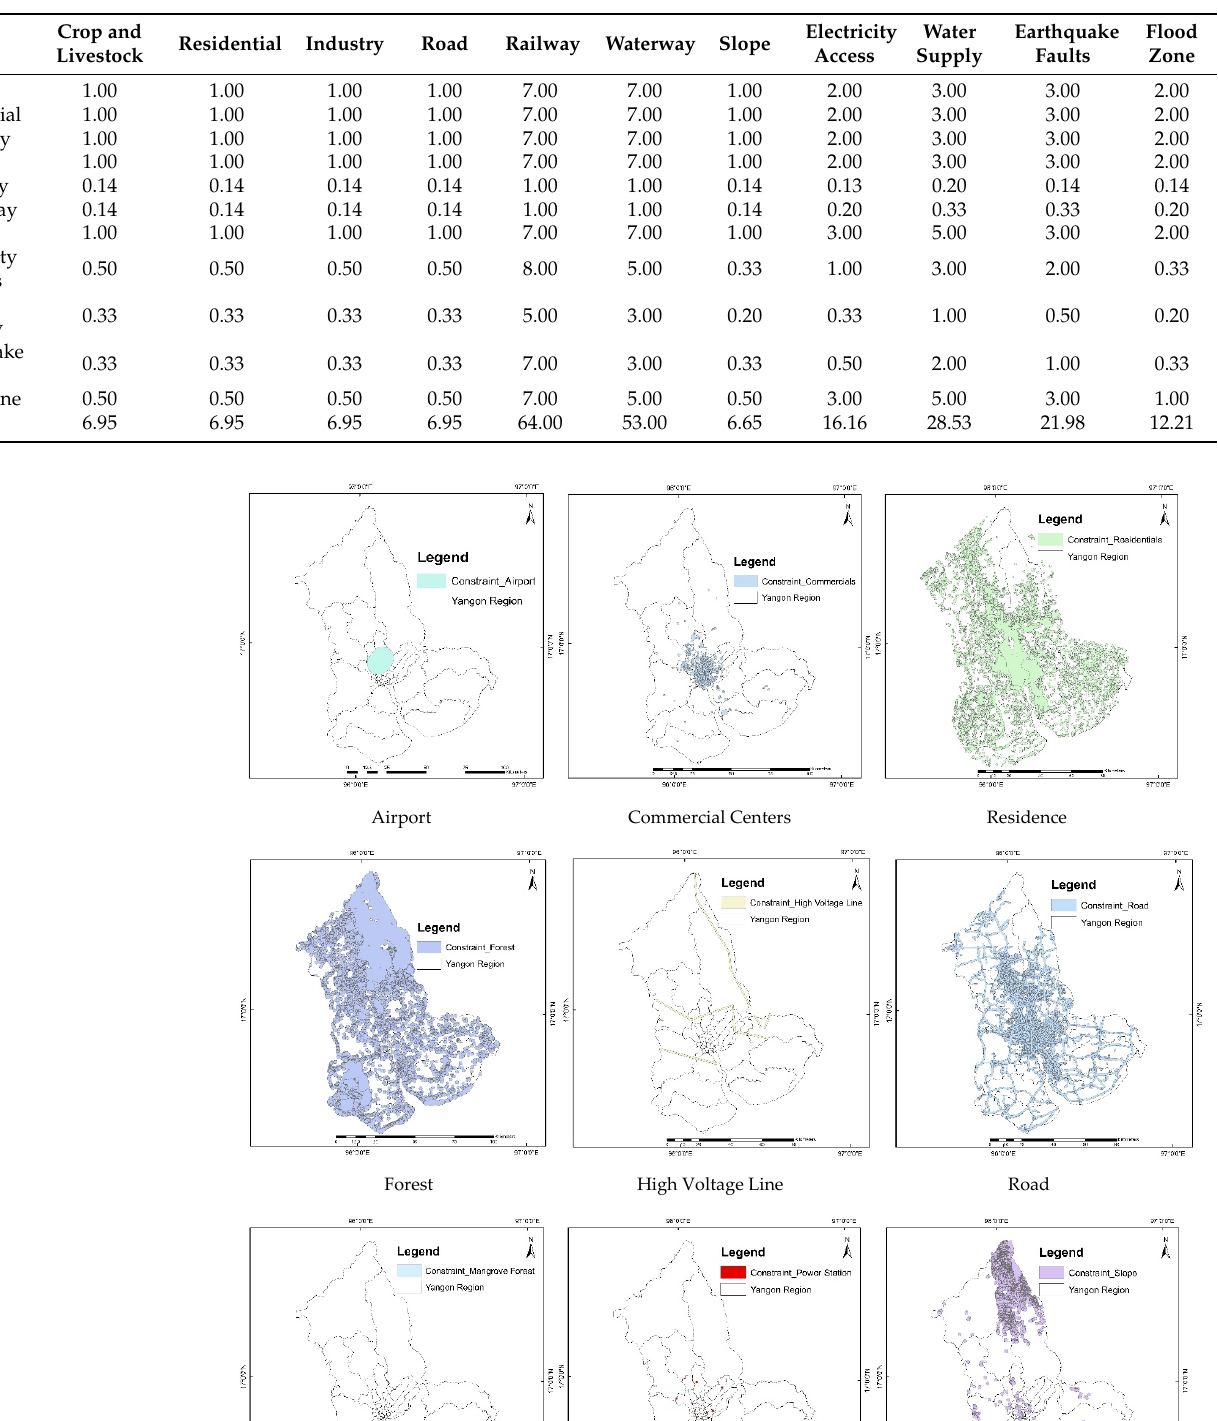
Table A5. Pairwise Comparison Matrix of